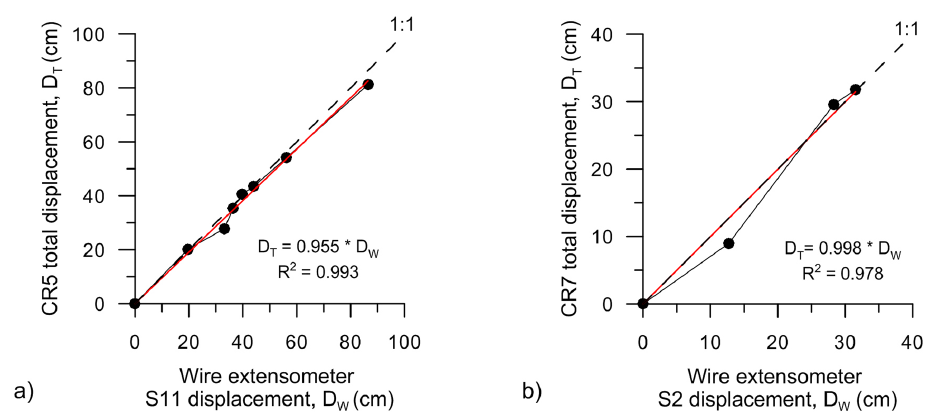
Fig. 10. Charts showing GB-SAR total displacement against wire extensometer displacement: (a) for CR5 and S11, between February 2010 and September 2011, and (b) for CR7 and S2, between February 2010 and November 2010. Red lines show the optimum linear fit to the data. Dashed lines show straight lines with a slope of 1 : 1.